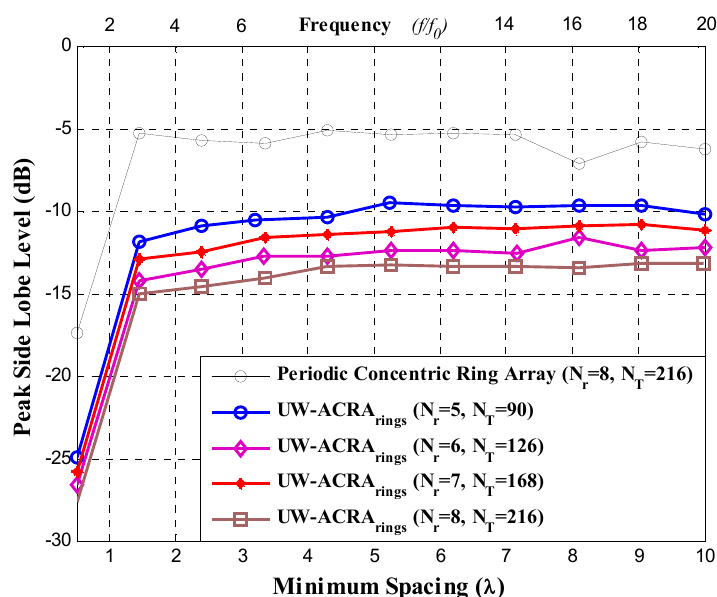
Figure 4. PSLL performance of the aperiodic concentric rings array (UW-ACRA rings ).